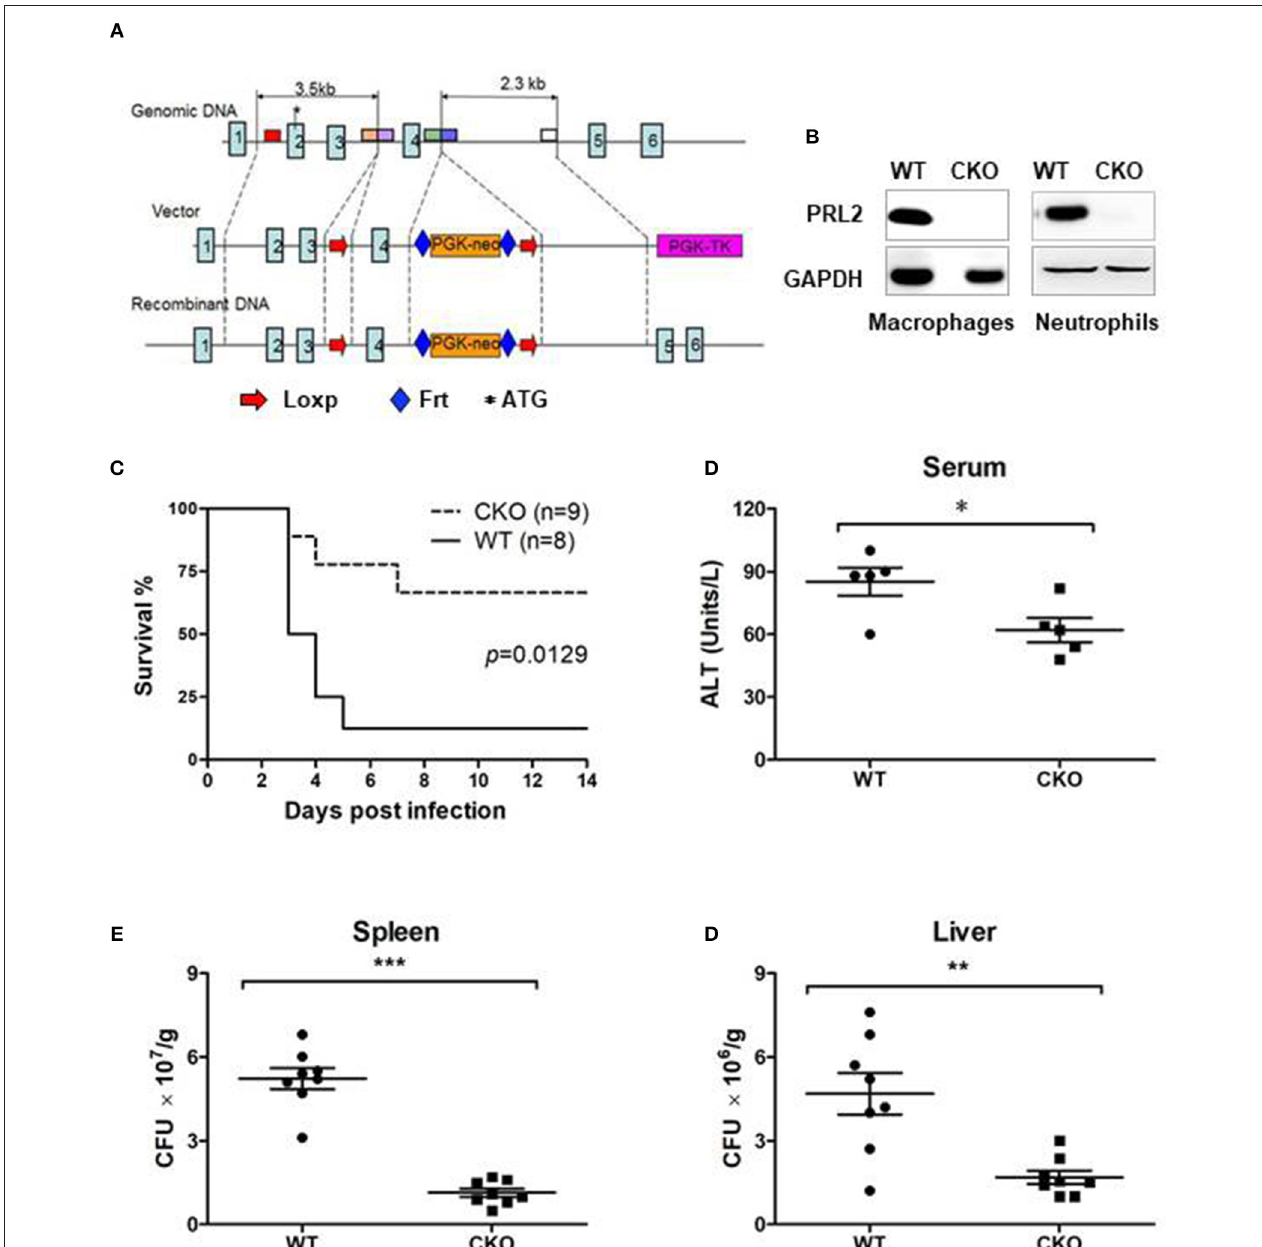
FIGURE 3 | PRL2 myeloid cell-deficient mice are resistant to lethal listeria infection . (A) The strategy of Ptp4a2 fl / fl mice. LoxP sites were inserted at both ends of exon 4 of the Ptp4a2 gene. (B) Peritoneal macrophages and bone marrow neutrophils were isolated from PRL2 myeloid cell conditional knockout mice (CKO) and their wild-type littermates (WT). Cell lysates were subjected to SDS-PAGE followed by immunoblot analysis using the indicated antibodies. (C) WT ( n = 8) and PRL2 CKO mice ( n = 9) were infected with 3.75 × 10 5 CFUs of L. monocytogenes i.v and the survival monitored. (D) Serum ALT levels were measured 24h post infection. (E,F) Liver and spleen CFUs were determined 24h post infection by colony-forming unit assay. Data are pooled from 2 independent experiments. Error bars represent the SD. * P < 0.05, ** P < 0.01, *** P < 0.005.